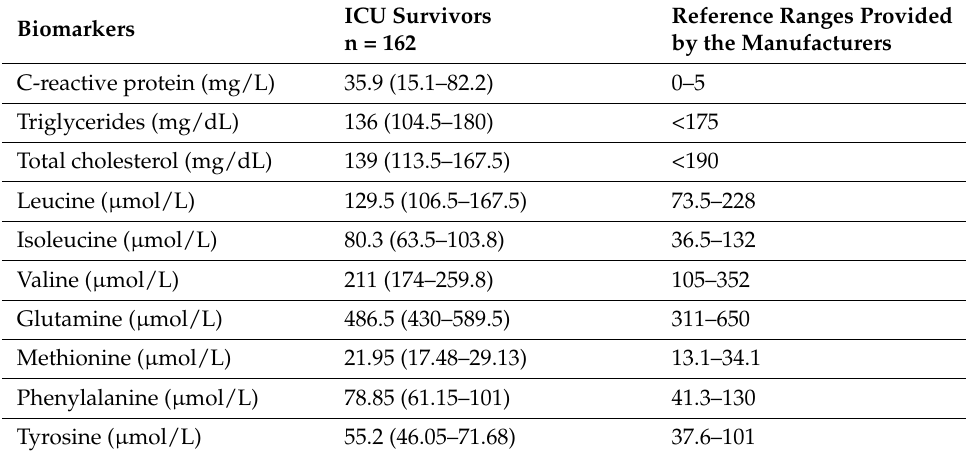
Table 3. Ancillary biochemical